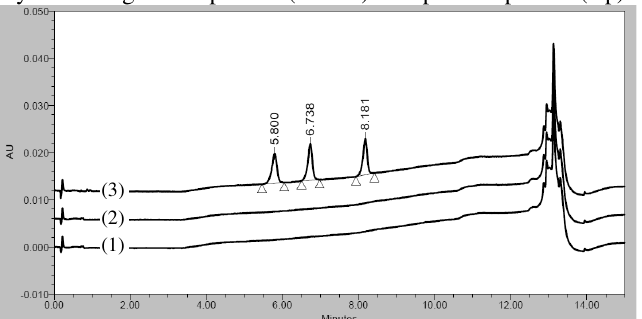
Figure 4. Overlay chromatograms of (1) blank; (2) placebo and (3) system suitability